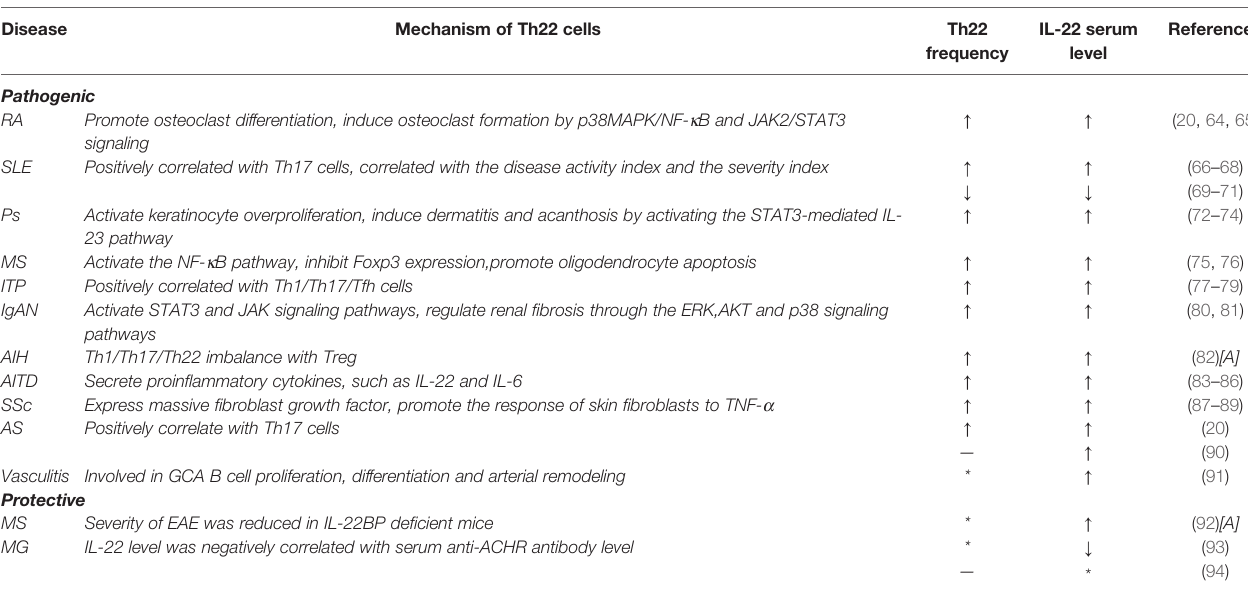
TABLE 1 | Dual role of Th22/IL-22 in autoimmune diseases.